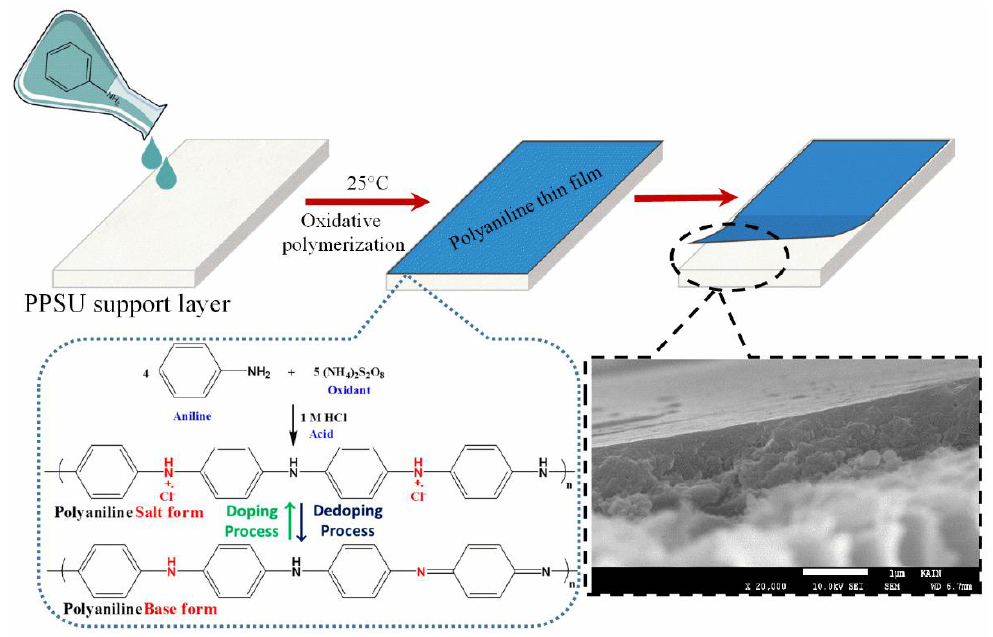
Figure 1. Schematic diagram of PANI thin film preparation via oxidative polymeriza-